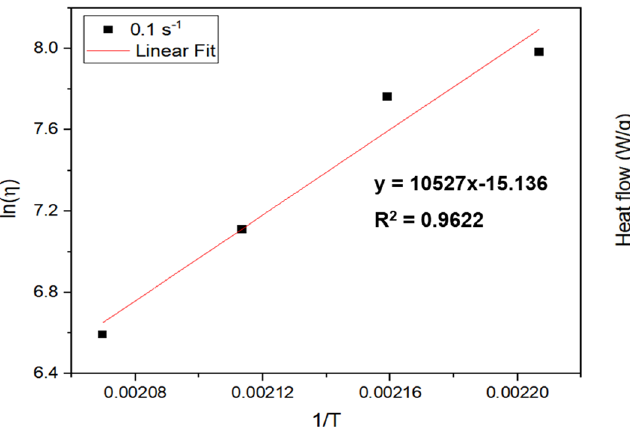
Figure 6: Dynamic DSC results ( 1st cooling and 2nd heating process )